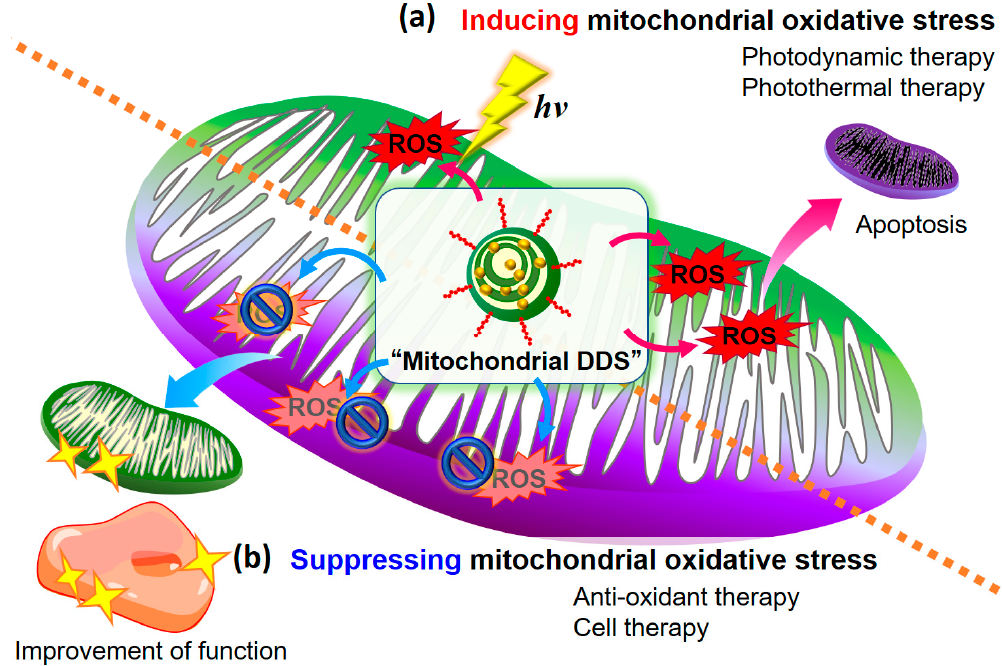
Figure 1. Schematic illustration of therapeutic strategies for regulating mitochondrial oxidative stress. Given that mitochondria are capable of producing reactive oxygen species (ROS) they are a source of oxidative stress. It follows that there are two types of therapeutic strategies for inducing and suppressing oxidative stress, which can be broadly divided into two main therapies. ( a ) Photodynamic and photothermal therapies by the mitochondrial delivery of photosensitizers that induce oxidative stress, thus leading to cell death. ( b ) Anti-oxidant therapy and cell therapy that deliver therapeutic molecules that suppress mitochondrial oxidative stress to mitochondria, removing ROS and improving mitochondrial and cellular functions.